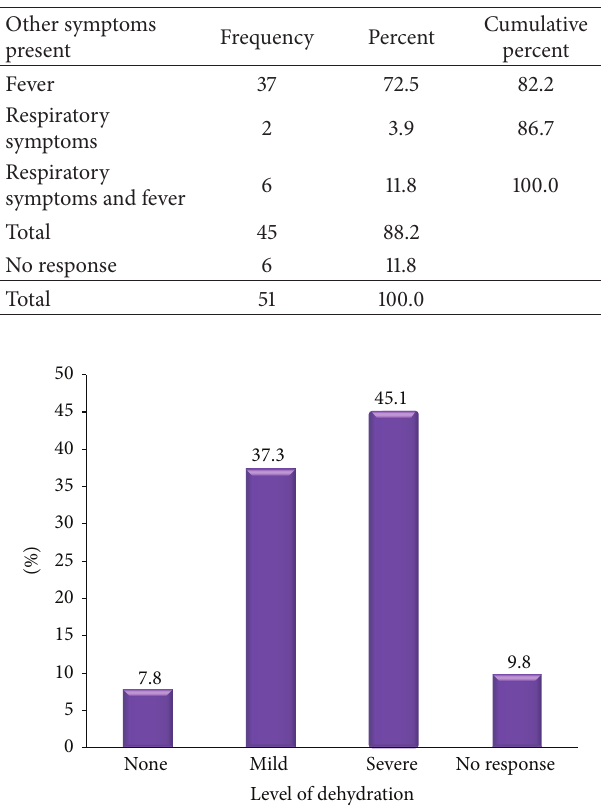
Table 4: Presence of other symptoms in rotavirus diarrhoea in children in Sokoto.